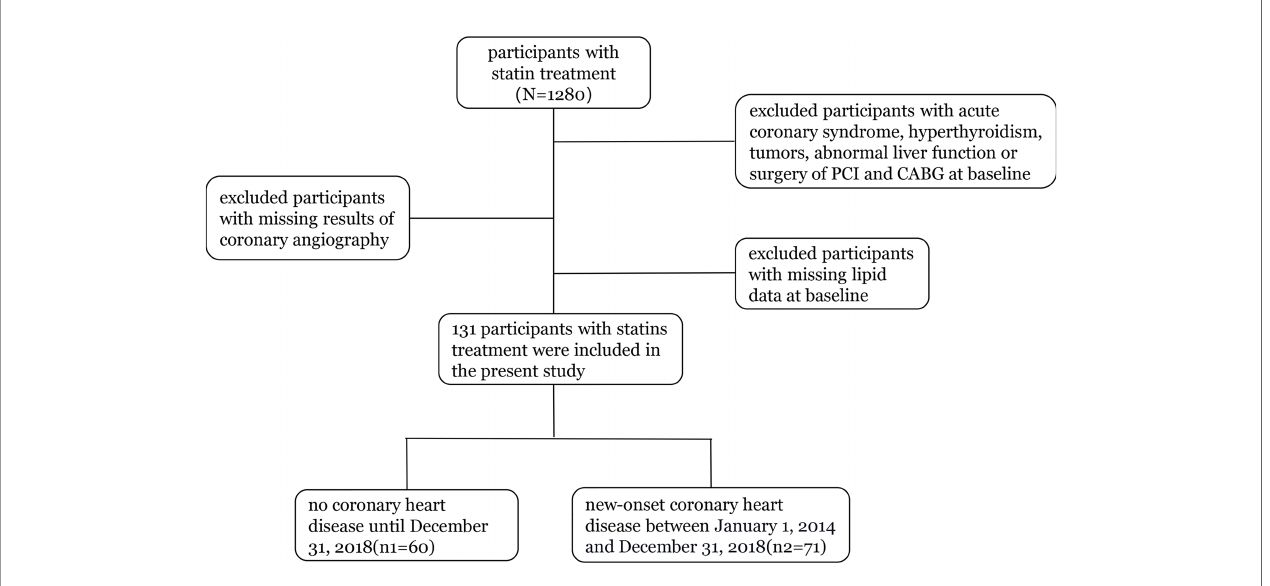
FIGURE 1 | Flow diagram of participants